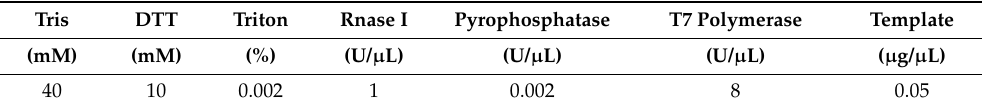
Table 2. Constant factors in in vitro